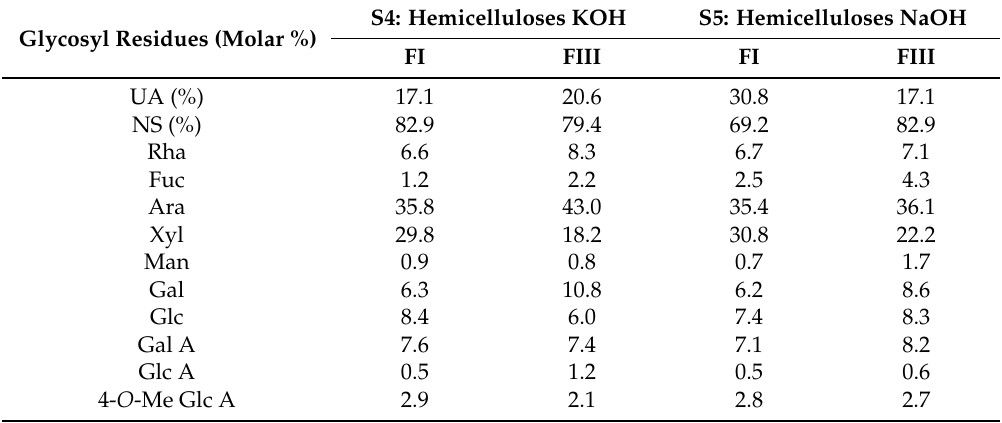
Table 3. Monosaccharidic composition determined by GLC of hemicellulosic fractions obtained after Sepharose gel CL-4B